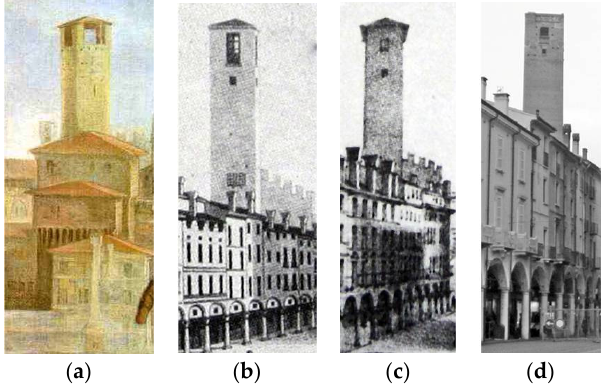
Figure 2. Views of the Gabbia tower dating back to: ( a ) 17th century; ( b ) 1830; ( c ) 1852; and ( d ) present days.